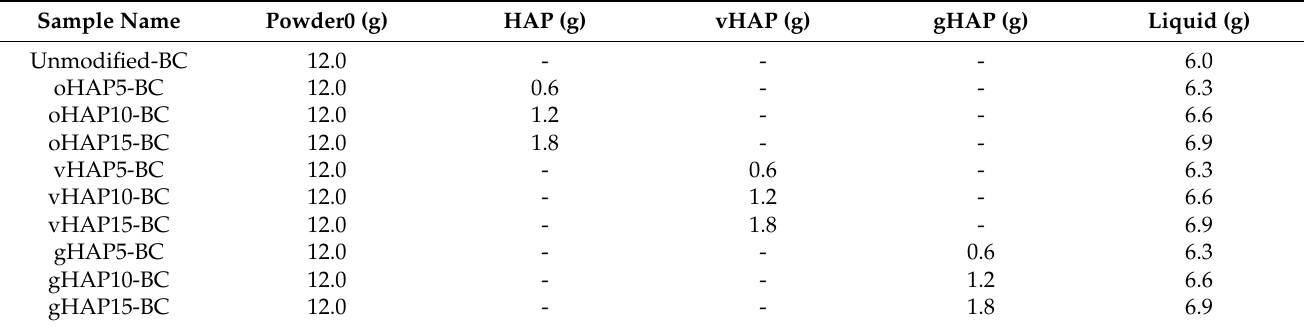
Table 1. Composition of PMMA bone cements modified with